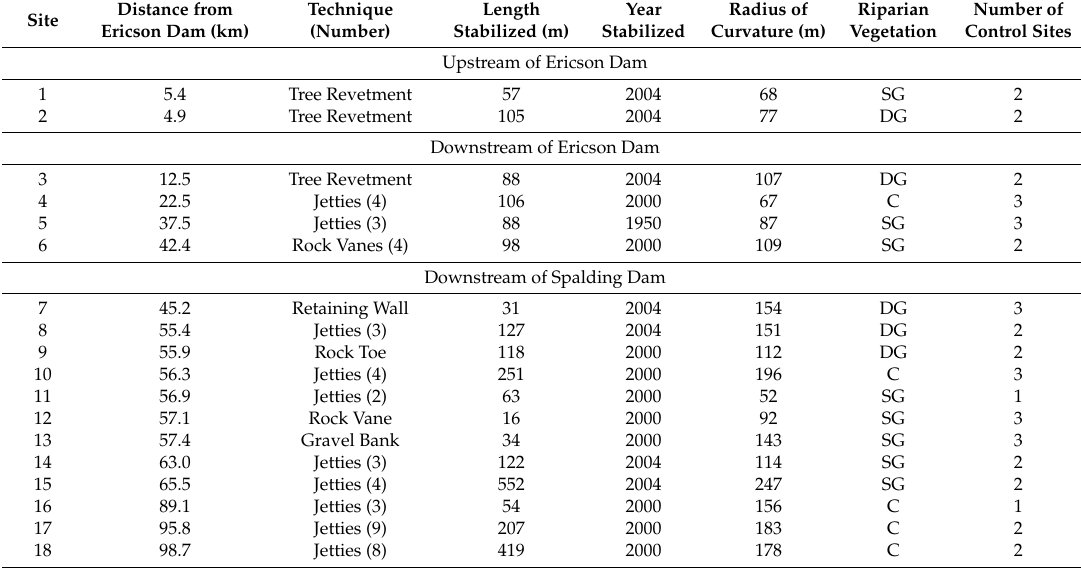
Table 1. Detailed description of all